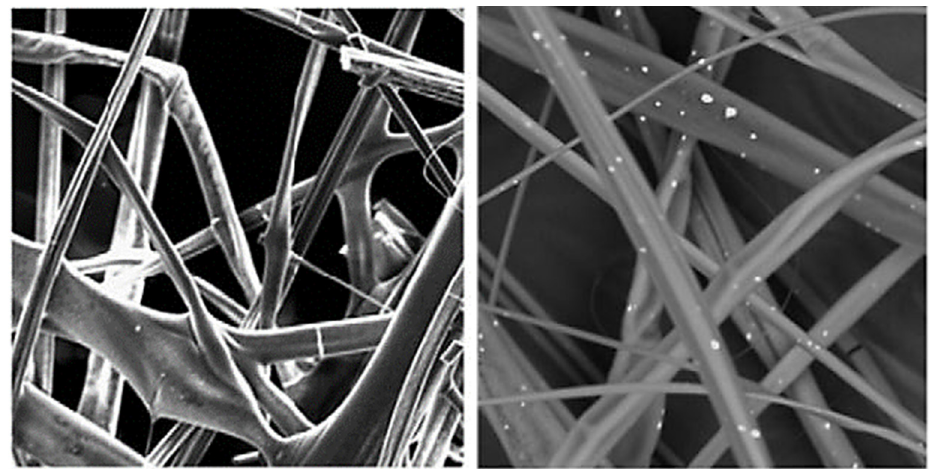
Figure 5. SEM images of PMMA fibre before ( left ) and after antimicrobial nanoparticles embedded into fibre mats ( right ). Reproduced with permission from Illangakoon et al., Materials Science and Engineering C ; published by Elsevier, 2017. [11].